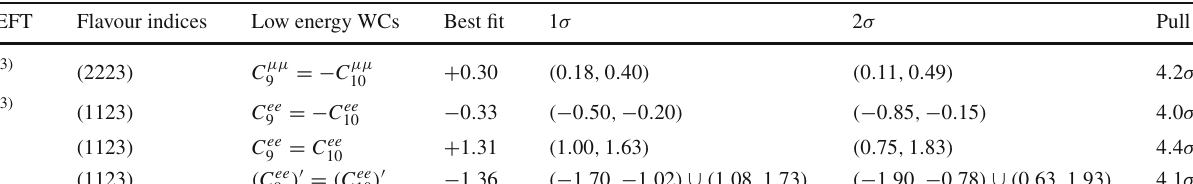
Table 1 List of viable single WCs in the SMEFT which accommodate R K ( ∗ ) , while being consistent with B ( B s → μμ) . The scale of new physics is considered to be (cid:3) = 20 TeV. Our results are in agreement with the fits performed in Refs. [14,15,26–29]